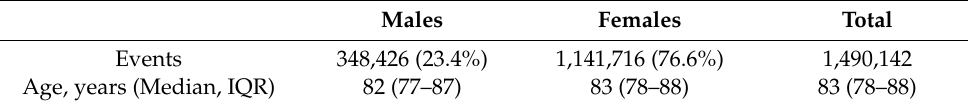
Figure 2. Left y-axis: raw incidence and age-adjusted incidence (events/100,000 adults >65 y/o) of hospitalization for proximal femoral fracture per year. Right y-axis: total number of fractures of the proximal femur per year. Table 1. Patients’ demographics .